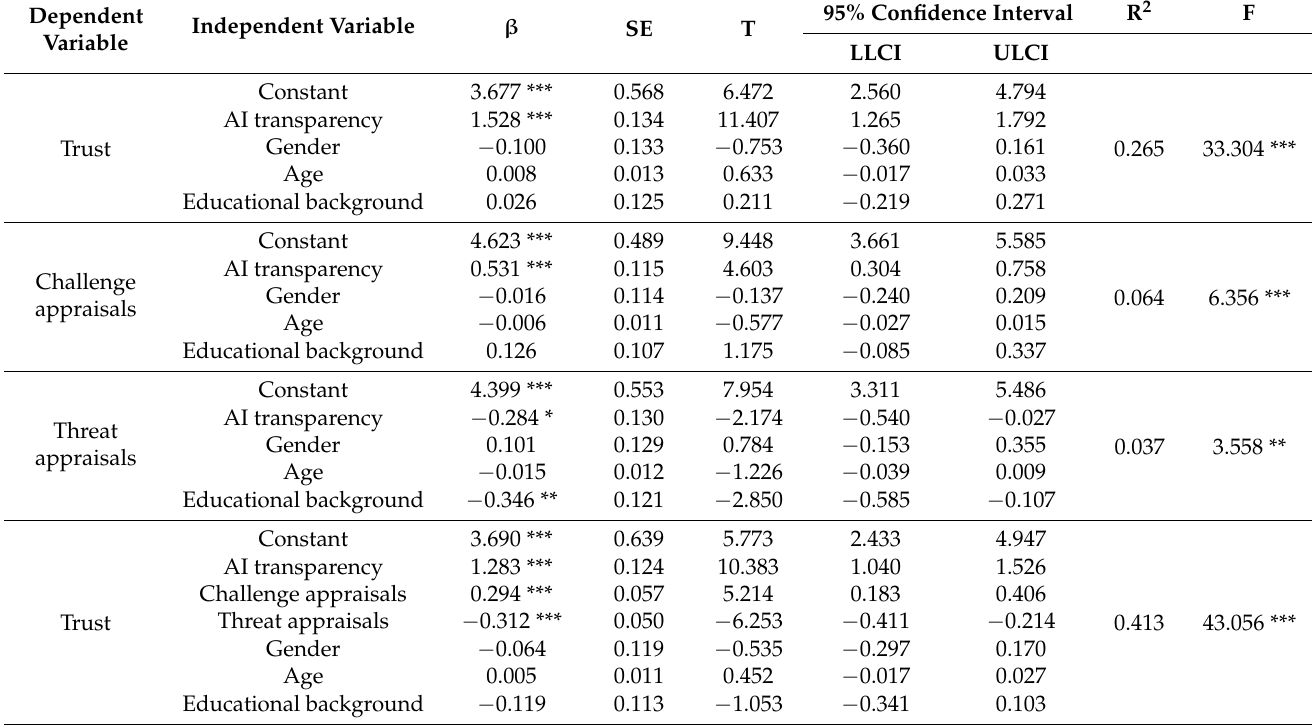
Table 6. The results of the mediating effect.